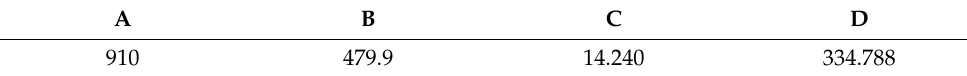
Table 3. Modified Voce constitutive equation coefficient of material TRIP780.